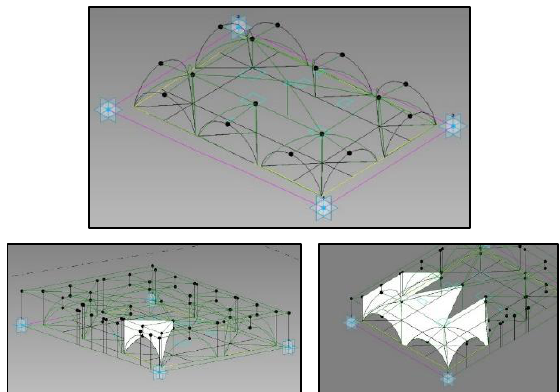
Figure 6. Modeling of the pavillon vaults and the lunettes